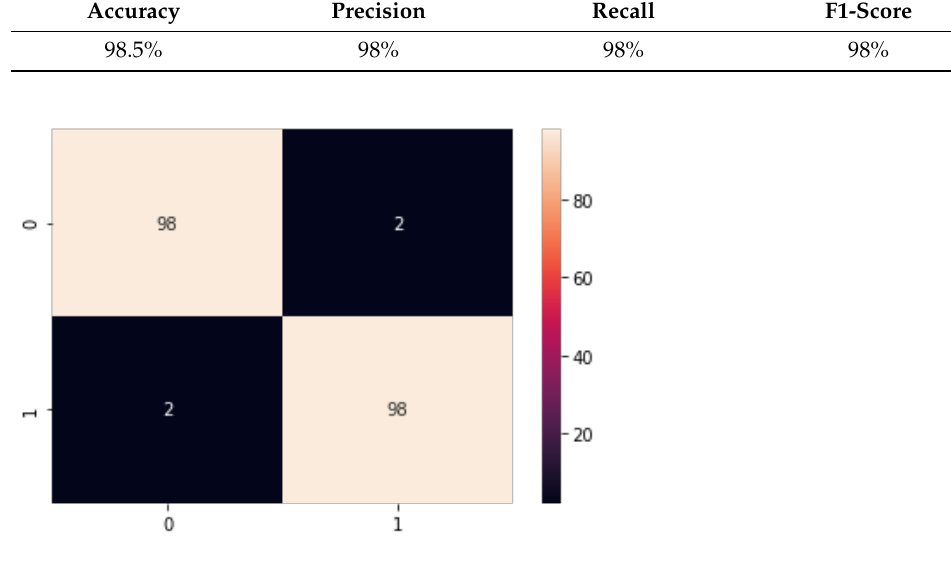
Figure 10. Confusion matrix.